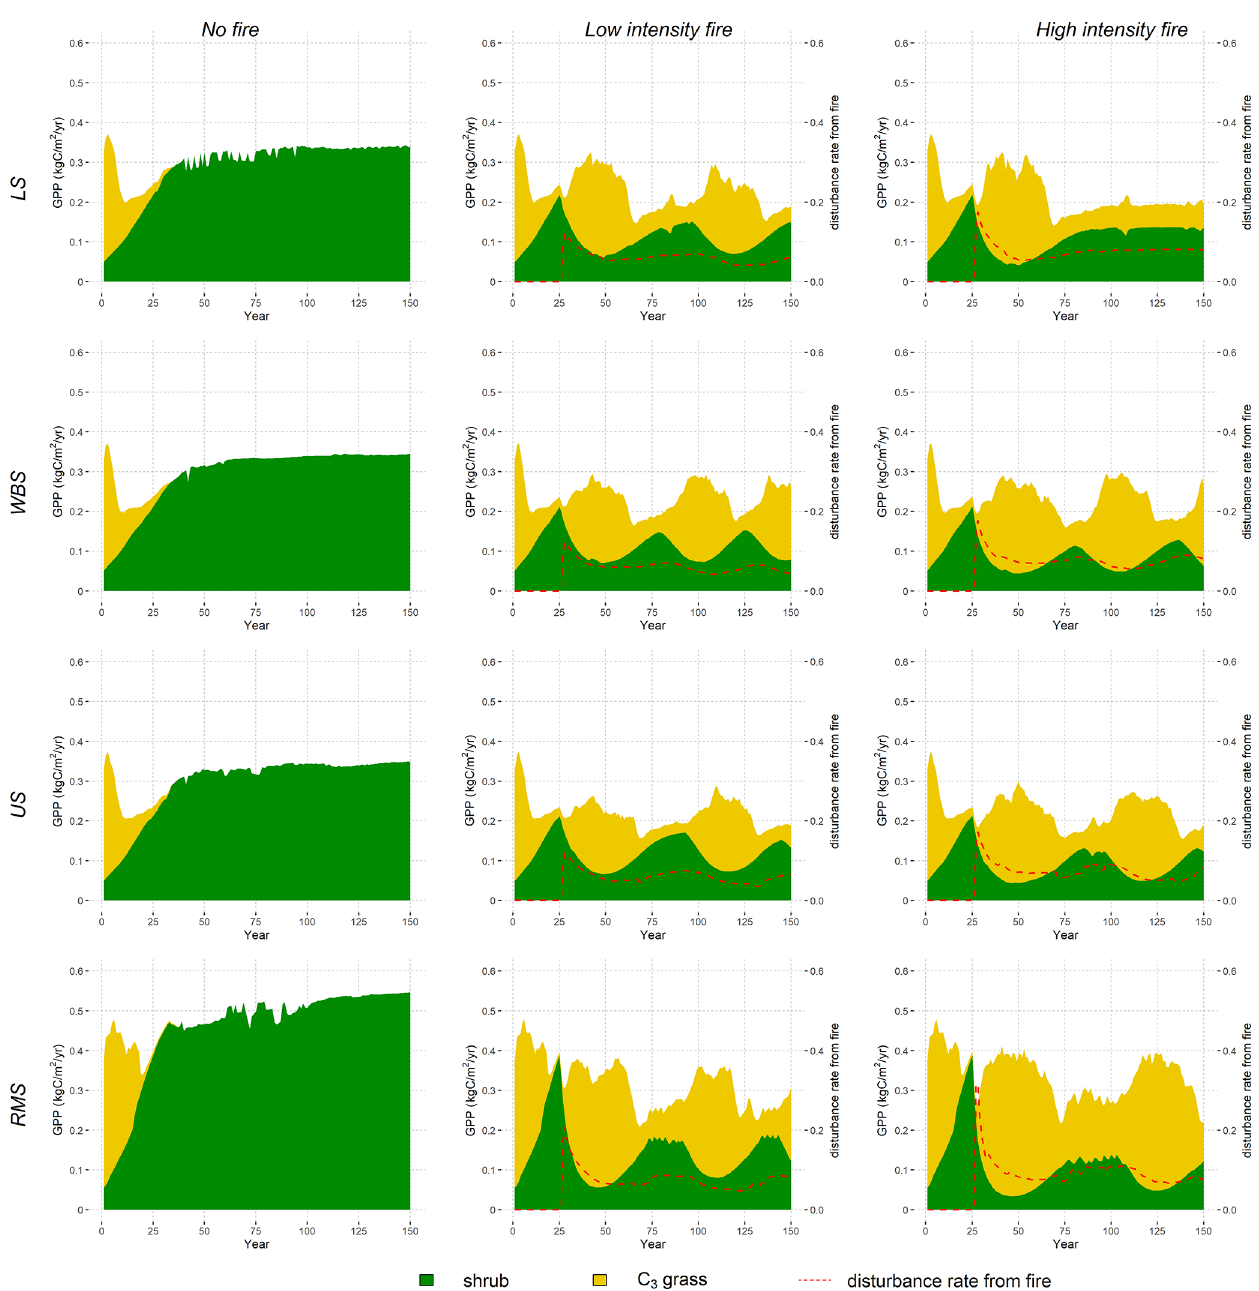
Figure 2. Mean annual trends in shrub, C 3 grass (temperate C 3 grass), and total GPP (kgCm − 2 yr − 1 ) (shrub and C 3 grass GPP shown stacked) simulated at four EC flux tower sites (LS, WBS, US, and RMS). Panels in the left column represent the trend in the no-fire condition; the middle column represents the low-fire-severity conditions; and the right column represents the high-fire-severity conditions. For the model runs with fire conditions, fire was introduced in the 25th year of simulation. The dashed red line is scaled by the secondary y axis (right), which shows mean fire disturbance rate for the simulation